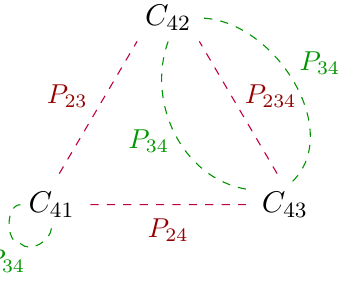
Fig. 4 Orbits of the secondary CWI’s under